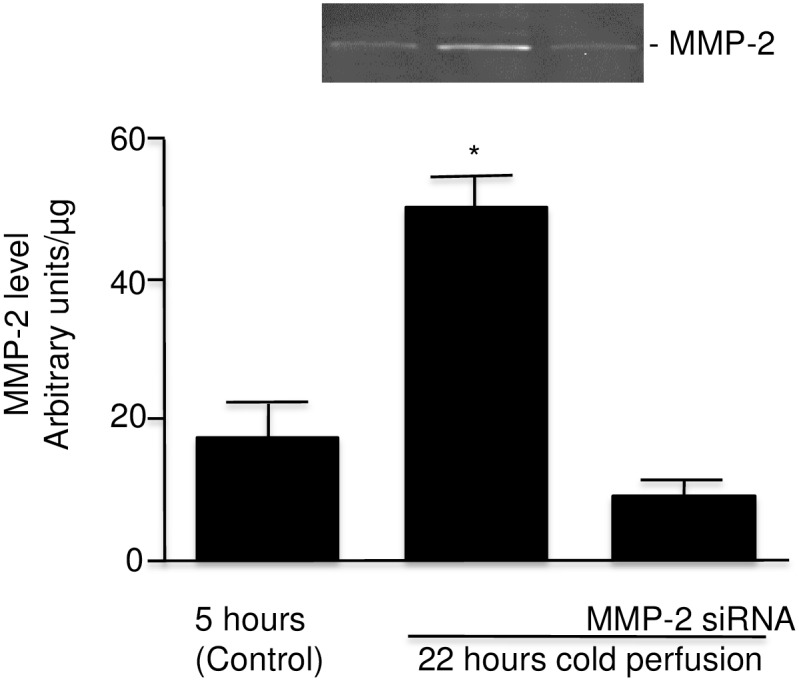
MMP-2 expression in perfusate from rat kidney cold perfused with KPS-1 solution with MMP-2 siRNA added (n = 4).Insert: a representative zymography for MMP-2. Error bars represent Standard Error of the Mean (SEM). * p<0.05 using Student’s T test. MMP = matrix metalloproteinase.